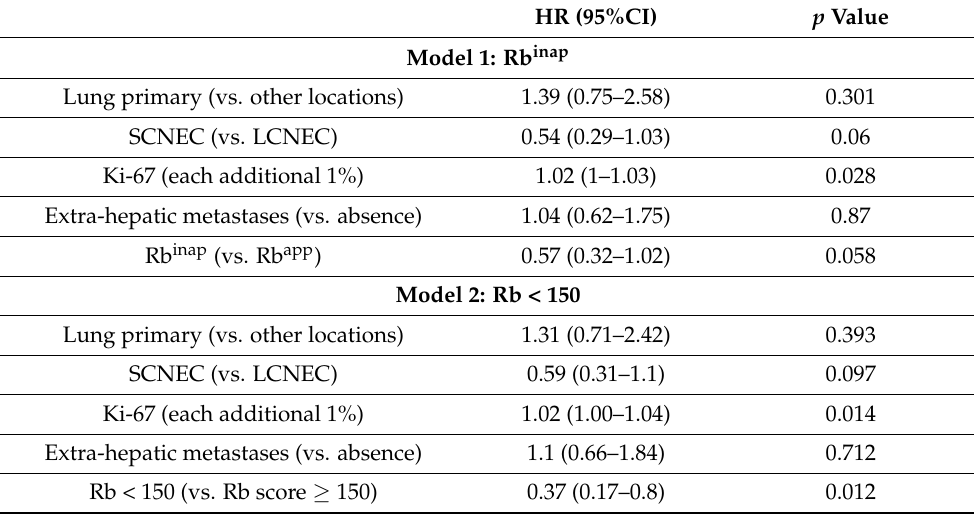
Table 3. Multivariate analysis of factors associated with the risk of progression among patients with